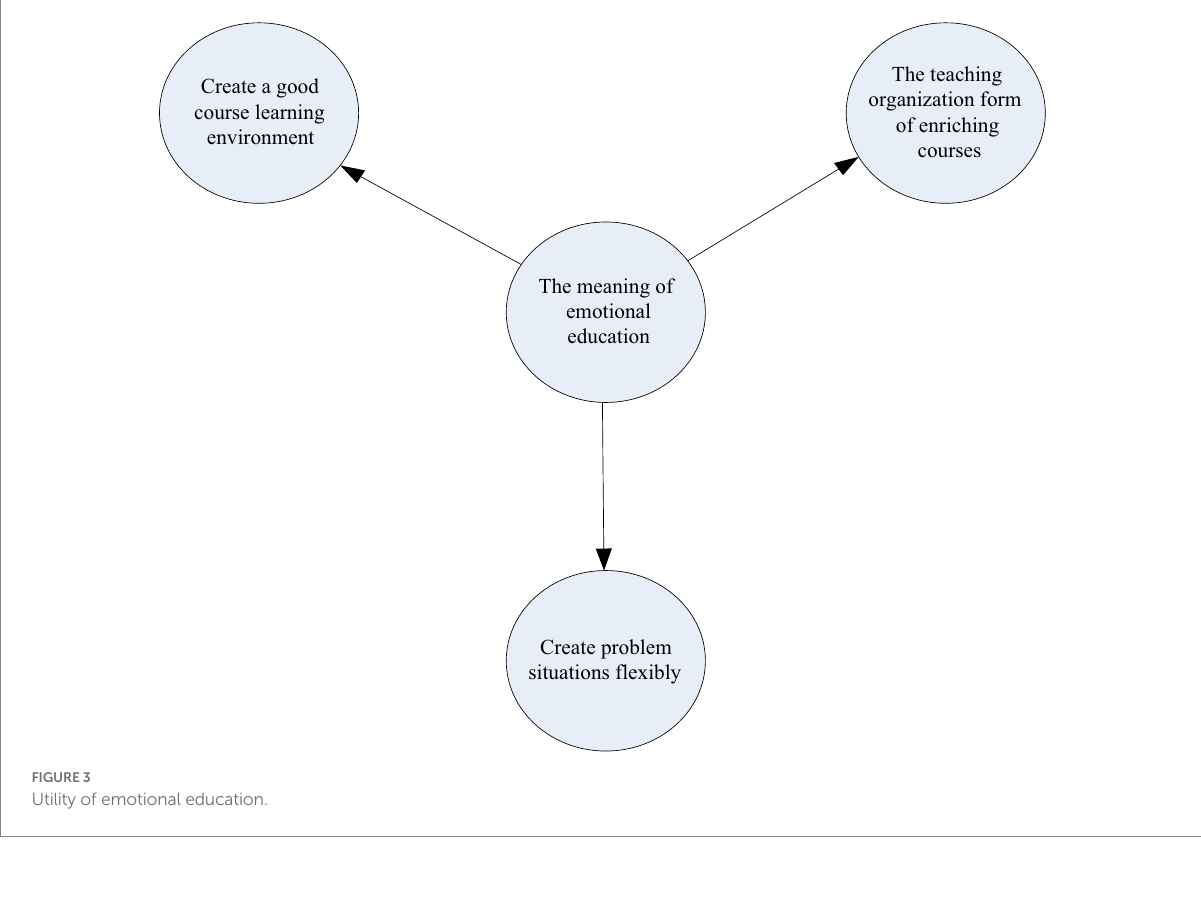
FIGURE 3 Utility of emotional education.